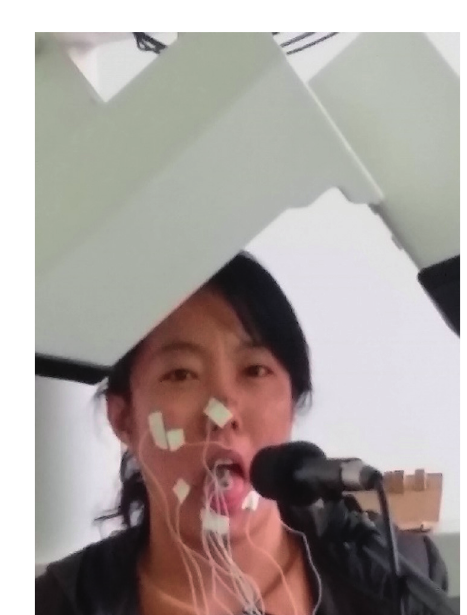
Figure 4: Sensor placements on occlusal bite plane.